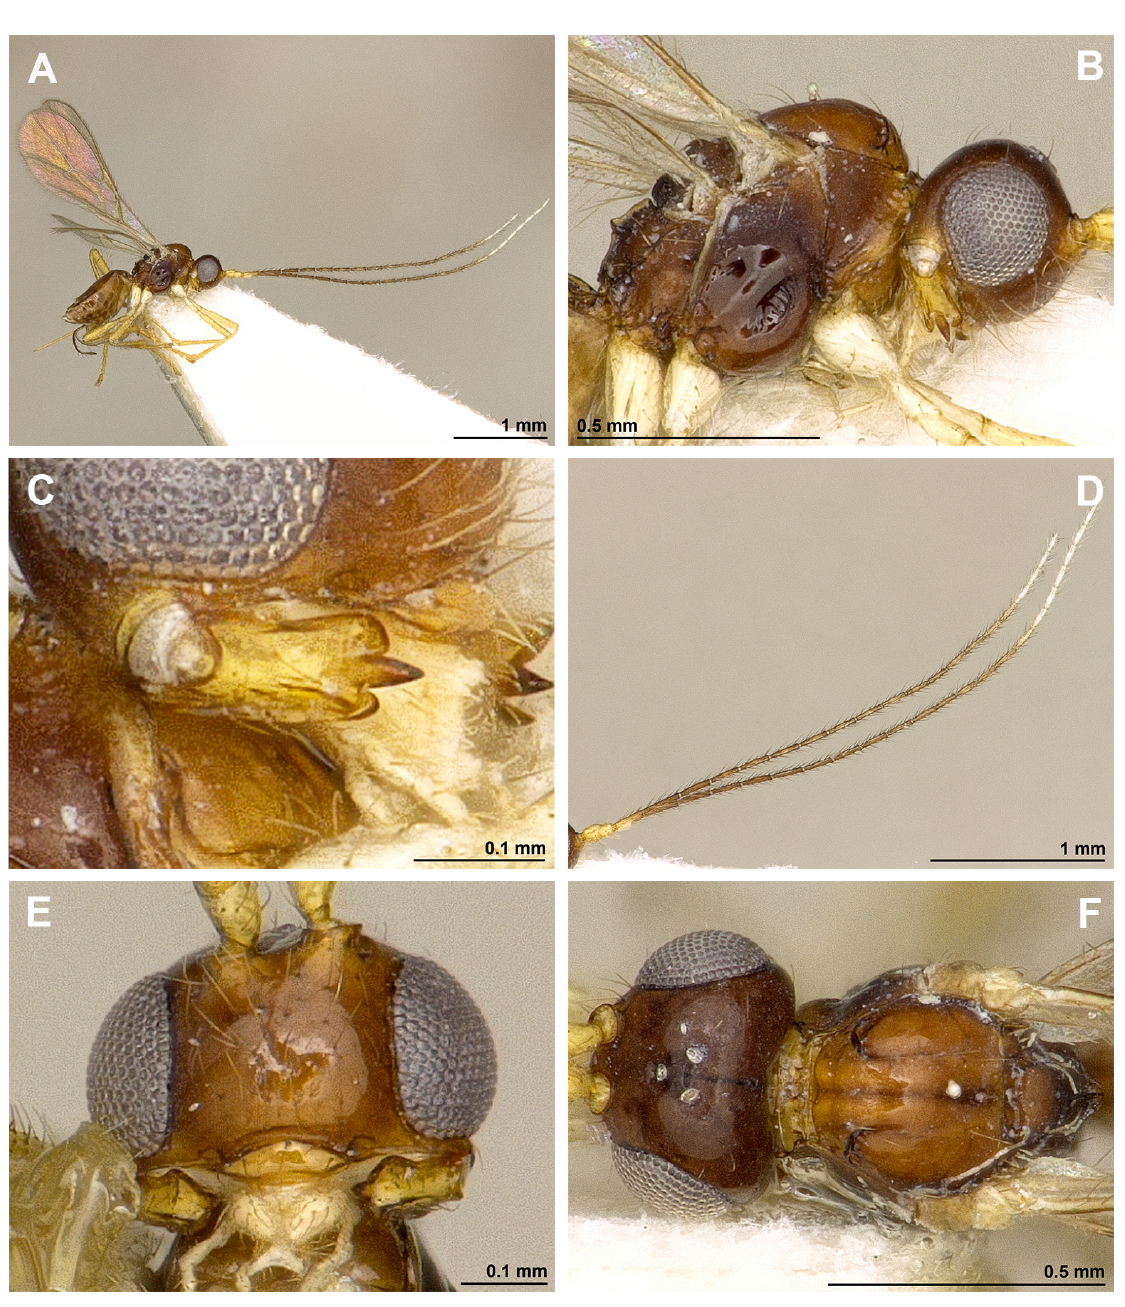
Fig. 35. Asobara laticlypeata van Achterberg, sp. nov., ♀, holotype (RMNH). A . Habitus, lateral view. B . Head and mesosoma, lateral view. C . Mandible. D . Antenna. E . Head, front view. F . Head and mesoscutum, dorsal